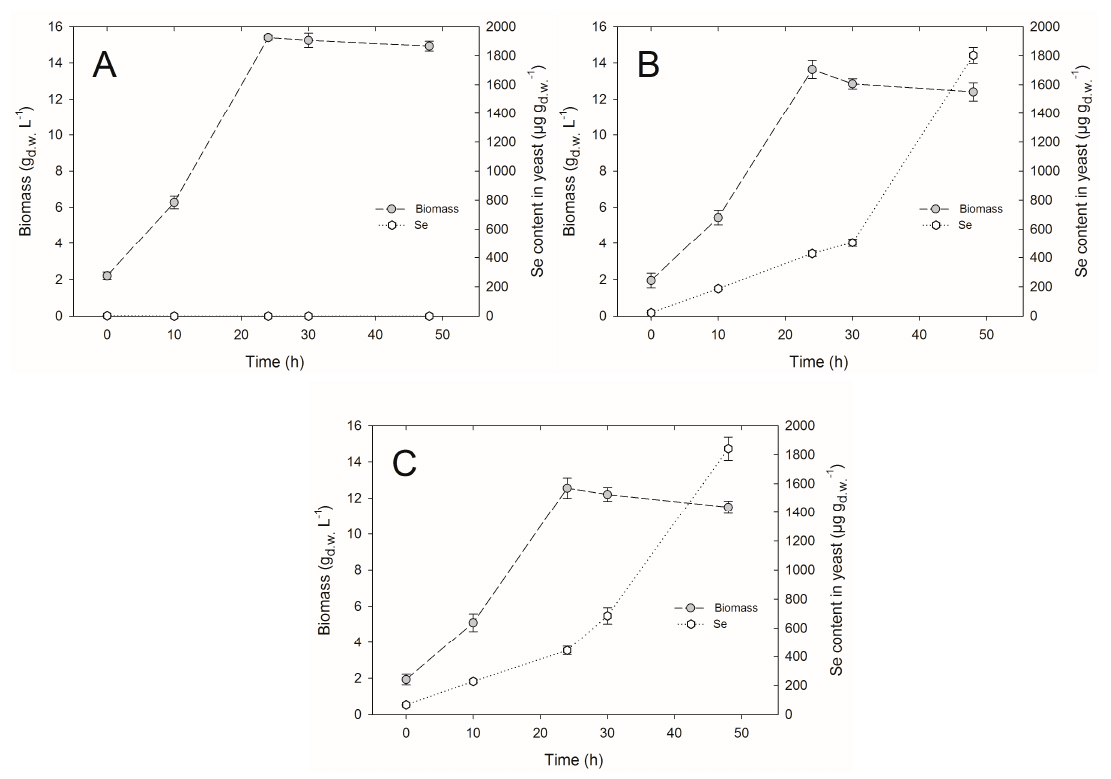
Figure 1. The culture of Candida utilis ATCC 9950 yeasts in ( A ) the control (yeast extract peptone dextrose, YPD) and in the experimental media enriched with selenium at ( B ) 20 mg ∙ L − 1 and ( C ) 30 mg ∙ L − 1 .